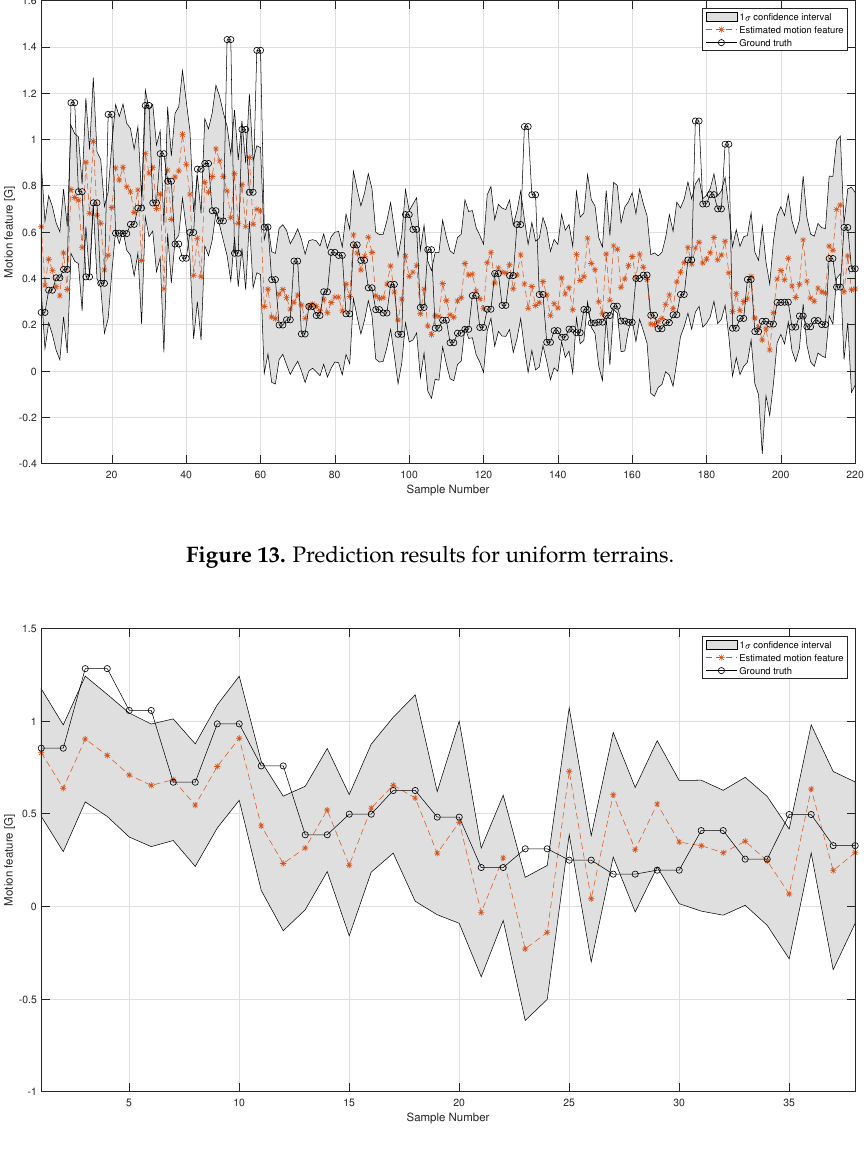
Figure 14. Prediction results for non-uniform